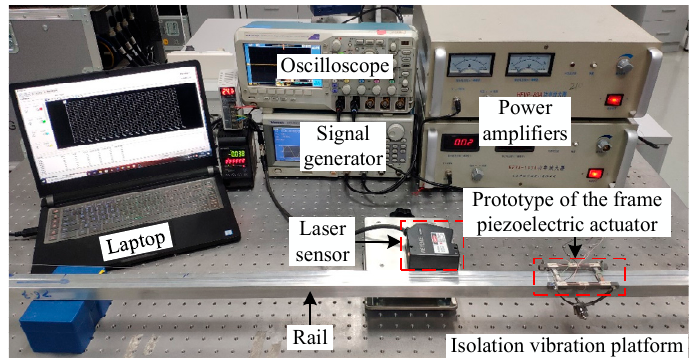
Figure 9. Experimental setup for measure mechanical performances of the actuator prototype.